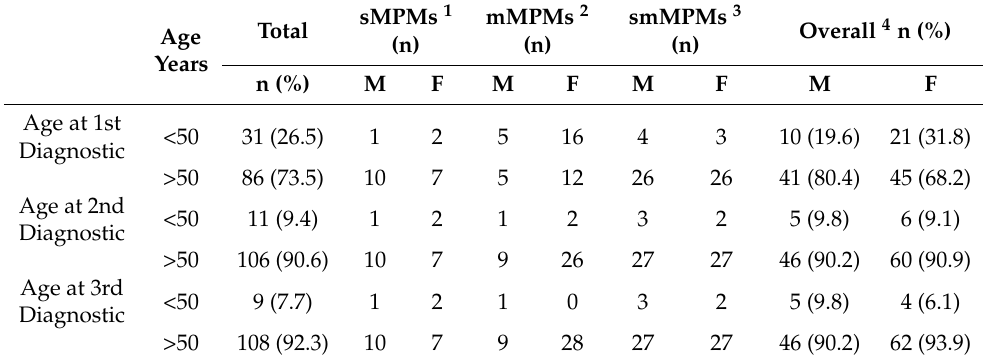
Table 2. Age distribution based on gender and tumor